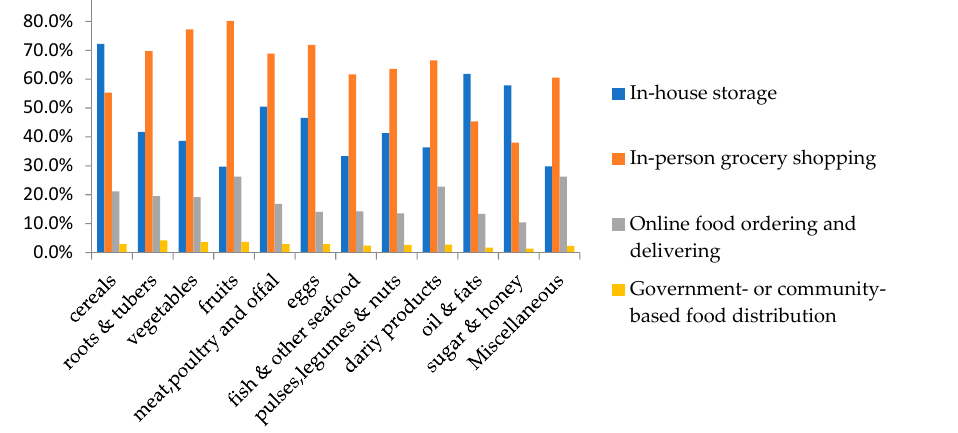
Figure 2. Participants’ choices of approaches to obtain or purchase foods during the isolation period (%).